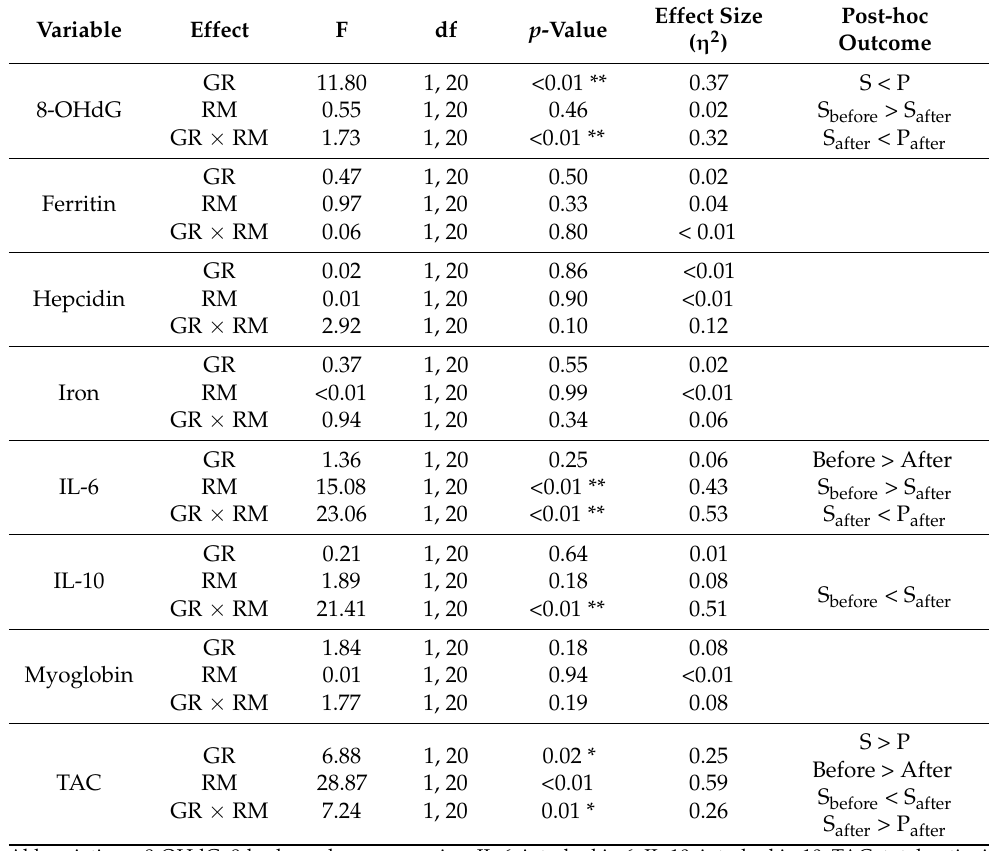
Table 4. Two-factor ANOVA with repeated measures (2 groups × 2 time points) of the resting serum levels of inflammatory markers before and after 90 days of supplementation with a lyophilizate of black chokeberry